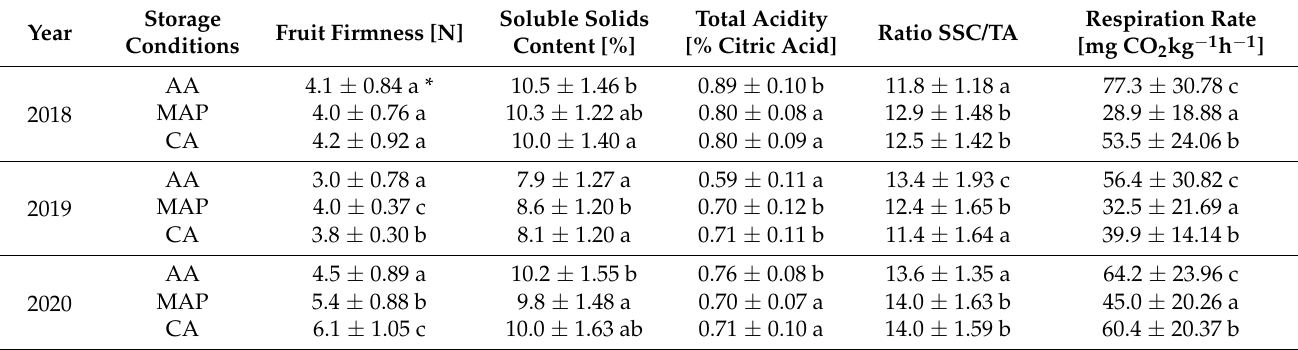
Table 6. Effect of storage conditions on the quality of ‘Murano’ strawberries and average for harvest